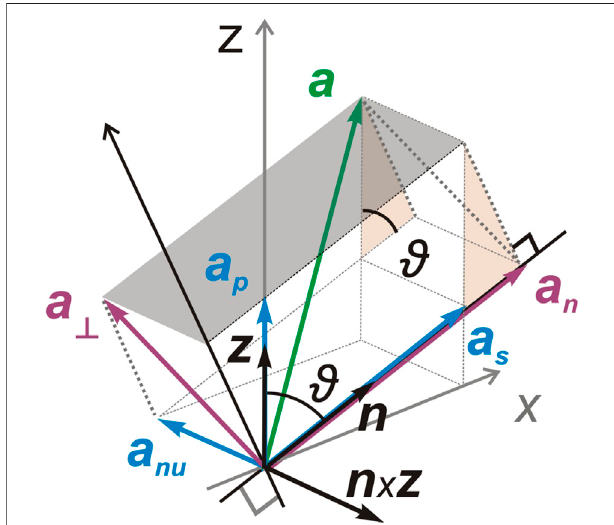
z , n × z . For the de fi nition of a n , a s and a p and a z , see Eq. 1 and the corresponding